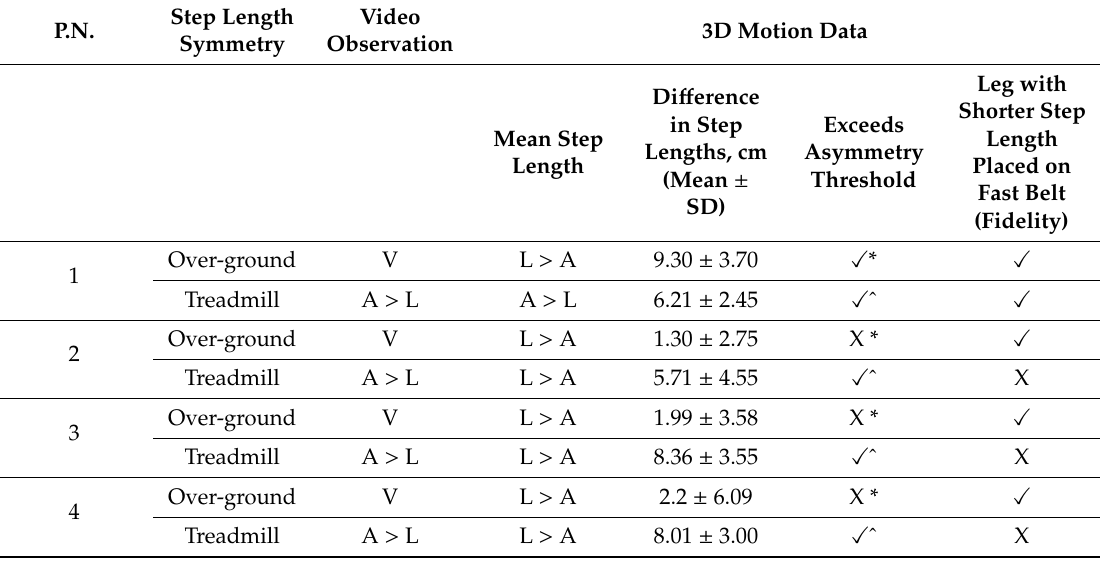
Table 3. Comparison of step length asymmetry direction and step length di ff